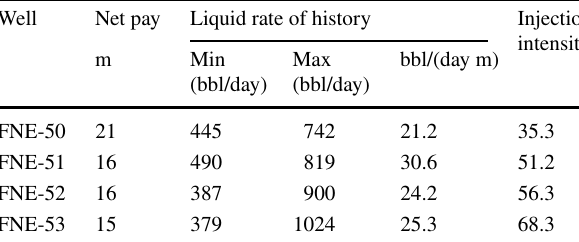
Table 6 Summary of injection index for injectors of